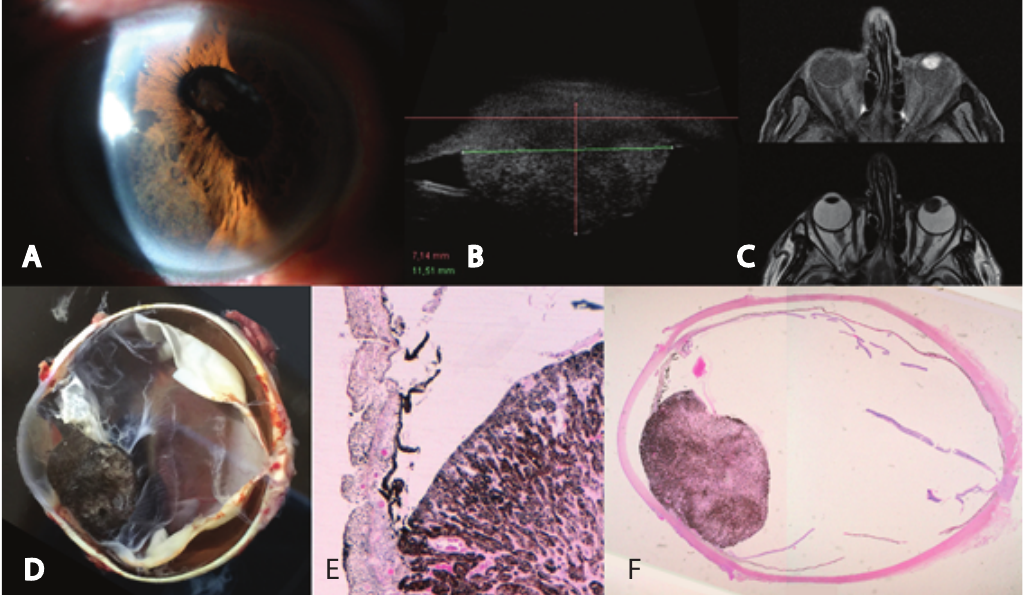
Figure 1. (A) Slit-lamp biomicroscopy showing an iris mass. (B) Ultrasound biomicroscopy. (C) Mass on T1- and T2-weighed magnetic resonance images. (D) Enucleated eye. (E&F) Hematoxylin and eosin stain, 4 × and low-power